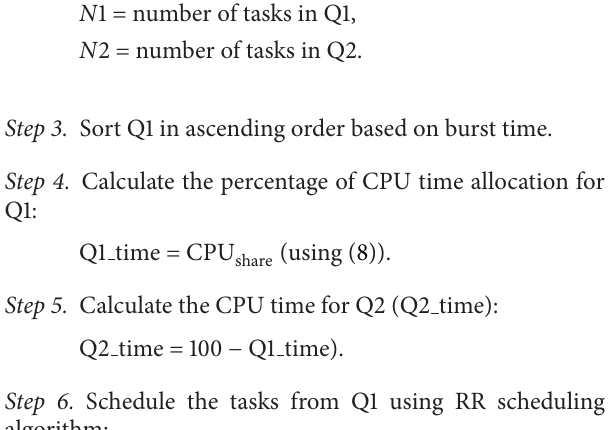
Figure 5: Task with maximum fuzzy value.